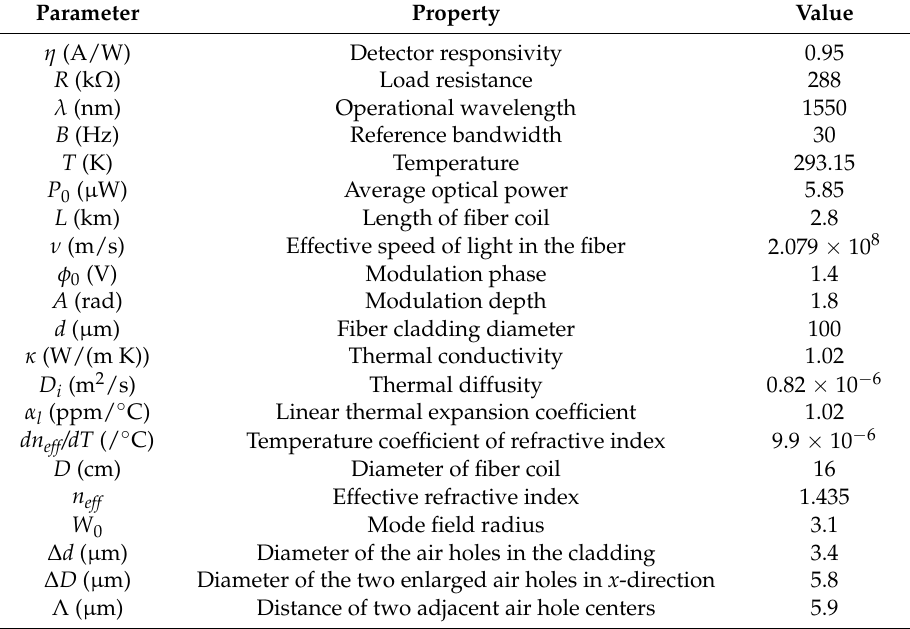
Table 1. Parameters of the experimental IFOG used in the computations.